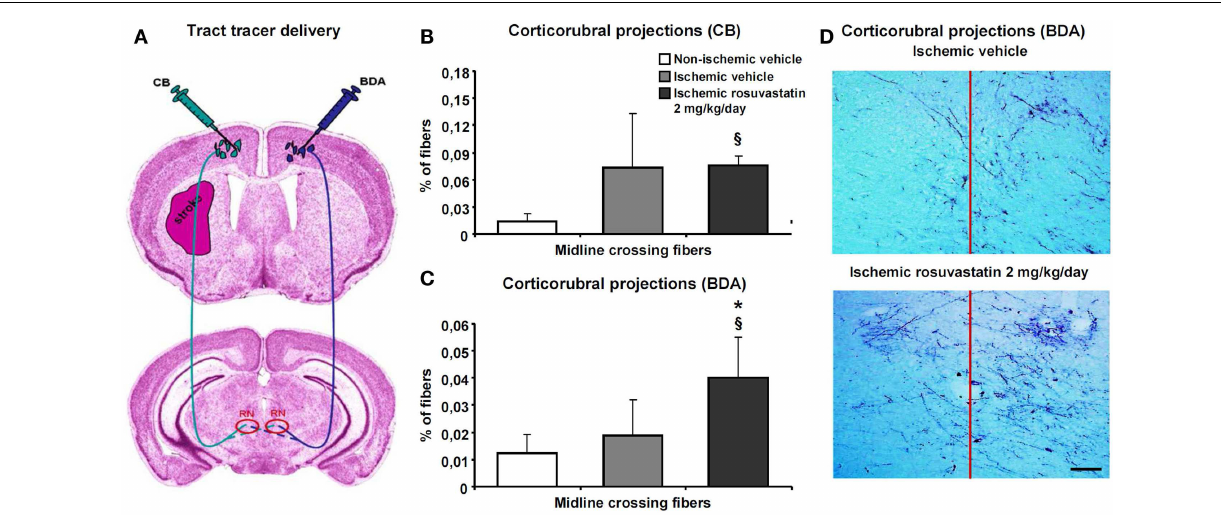
FIGURE 4 | Rosuvastatin promotes contralesional corticorubral plasticity .Tract tracing analysis of corticorubral projections ipsilateral and contralateral to the stroke in mice receiving cascade blue (CB) and biotinylated dextran amine (BDA) injections into the lesion-sided and contralesional motor cortex [for experimental procedures see (A) ]. Percent of midline-crossing fibers to (B) the contralesional red nucleus (RN) traced by CB and (C) ipsilesional red nucleus traced by BDA. Note that the percentage of midline-crossing fibers after ipsilesional CB injection increases in response to stroke (though not significantly) (B) . Importantly, rosuvastatin, delivered at a dose of 2mg/kg/day, does not further elevate the